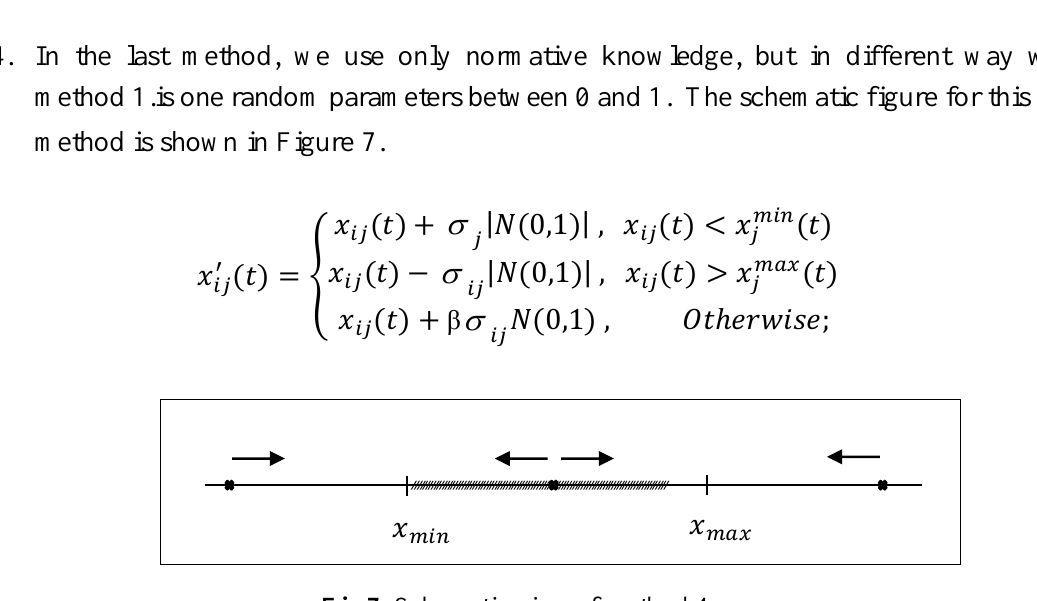
Fig 7 . Schematic view of method